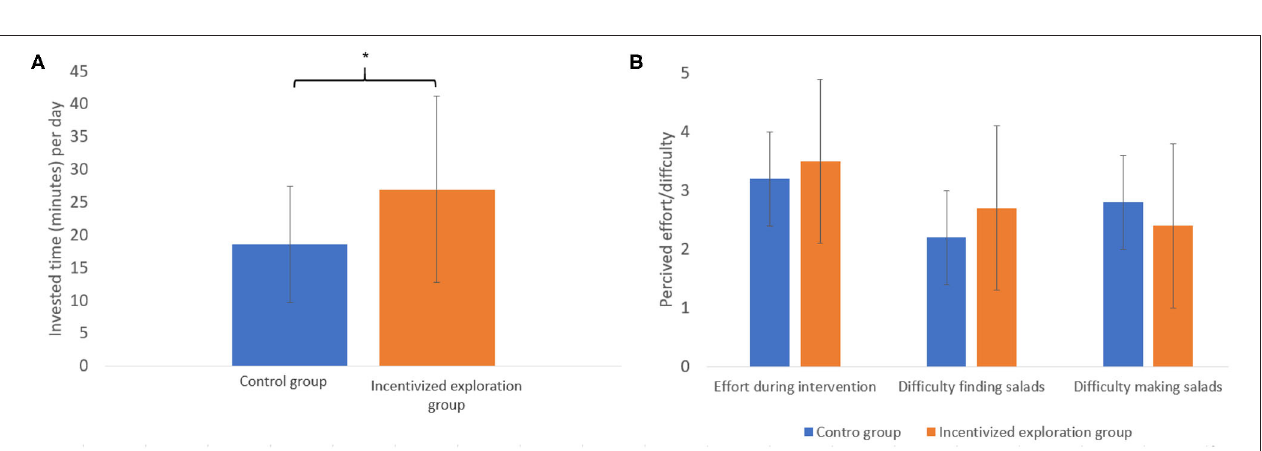
FIGURE 4 | Between groups differences regarding various aspects of effort during the intervention. (A) Difference in the average amount of time participants reported spending on the study during the intervention period. (B) The average of various aspects of reported self-perceived effort related to the intervention. * p <